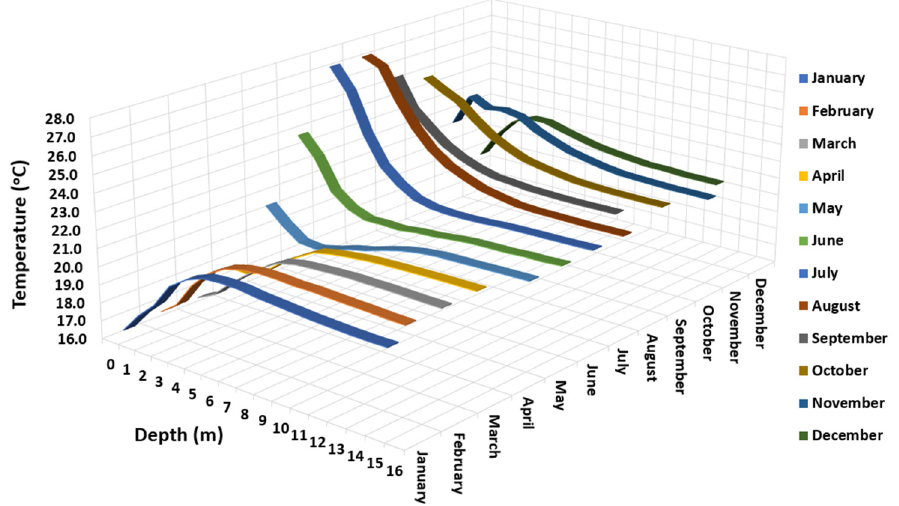
Figure 4. Average TDPTS for the whole period in piezometer P-8.